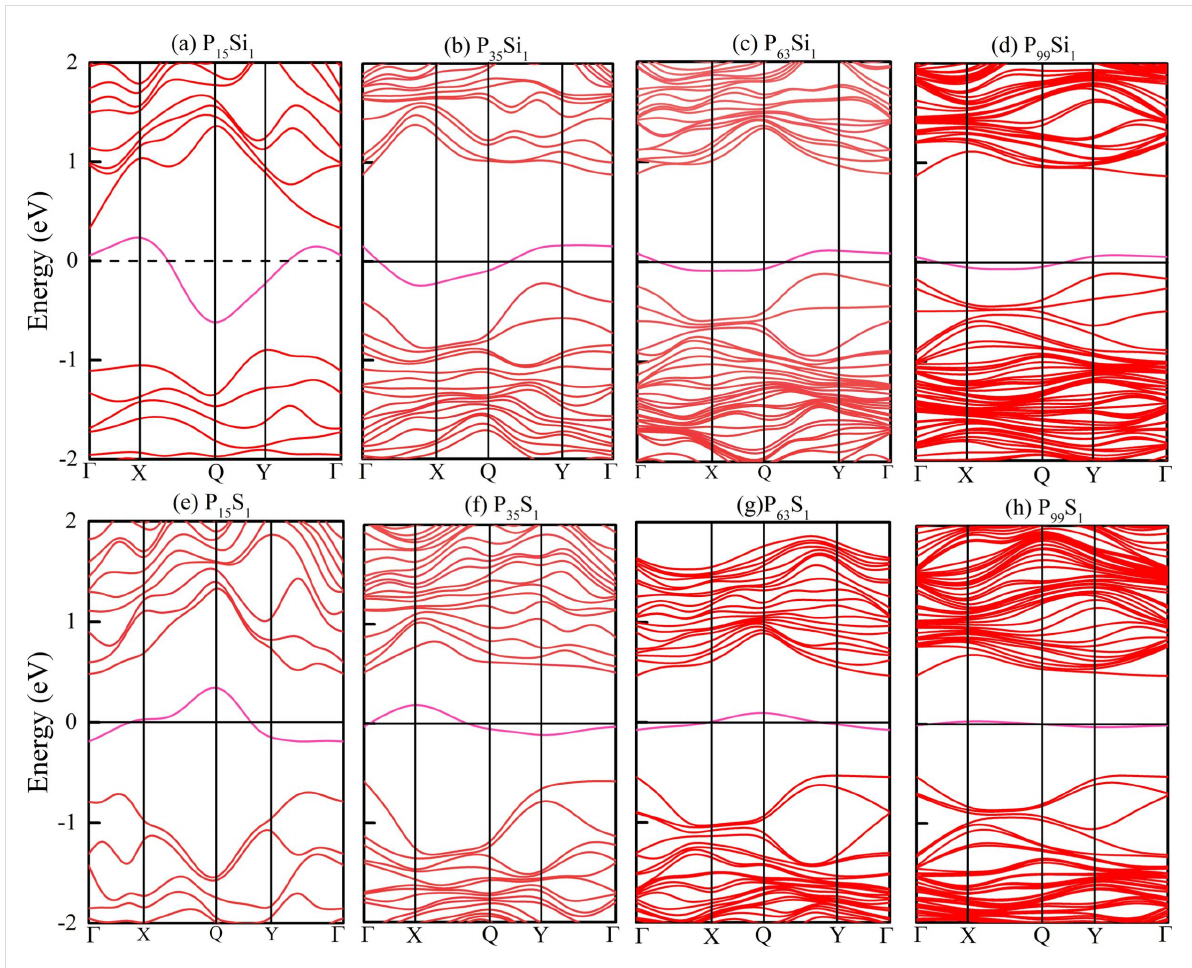
Figure 2: Band structures of Si- and S-doped phosphorenes without spin polarization. (a–d) Band structures of Si-doped phosphorene with (a) 2 × 2 × 1, (b) 3 × 3 × 1, (c) 4 × 4 × 1 and (d) 5 × 5 × 1 supercells, respectively; (e–h) band structures of S-doped phosphorene with (e) 2 × 2 × 1,